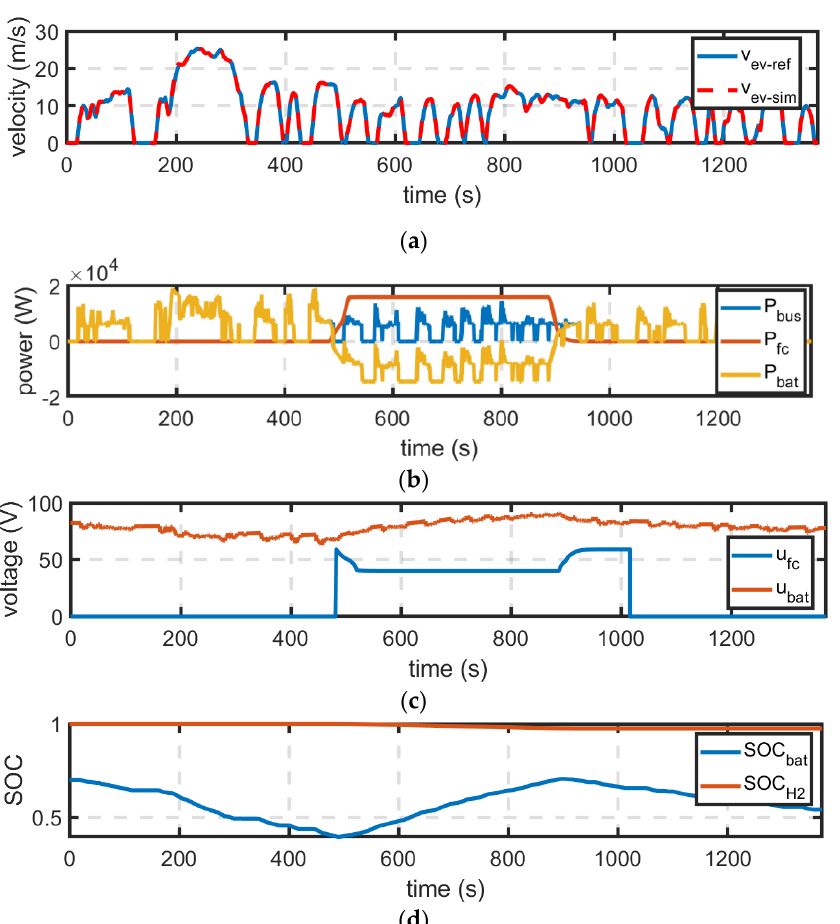
Figure 9. Vehicle simulation results for FTP-72 cycle under rule-based control strategy: ( a ) Results of variation of vehicle reference and actual velocity; ( b ) power variation of bus, fuel cell, and battery with time; ( c ) voltage variation of fuel cell and battery; ( d ) variation in state of charge of battery and hydrogen tank.